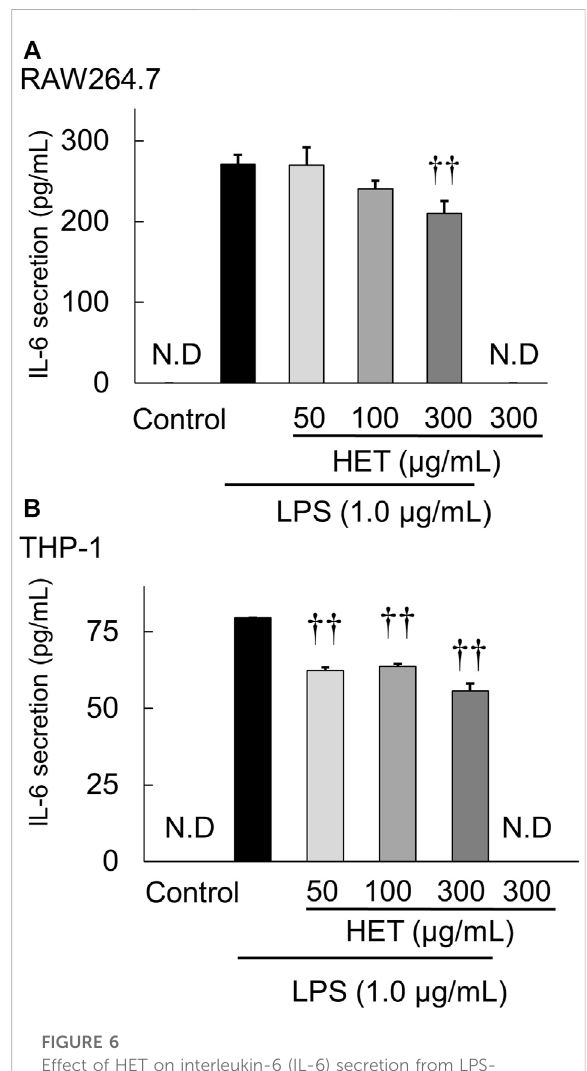
FIGURE 6 Effect of HET on interleukin-6 (IL-6) secretion from LPS- stimulatedRAW264.7 (A) andTHP-1 (B) macrophagesincubatedin the presence or absence of various concentrations (50 – 300 µg/ ml) of HET. Data are shown as mean ± SEM; n = 4 per group. †† : p < 0.01 (vs. LPS